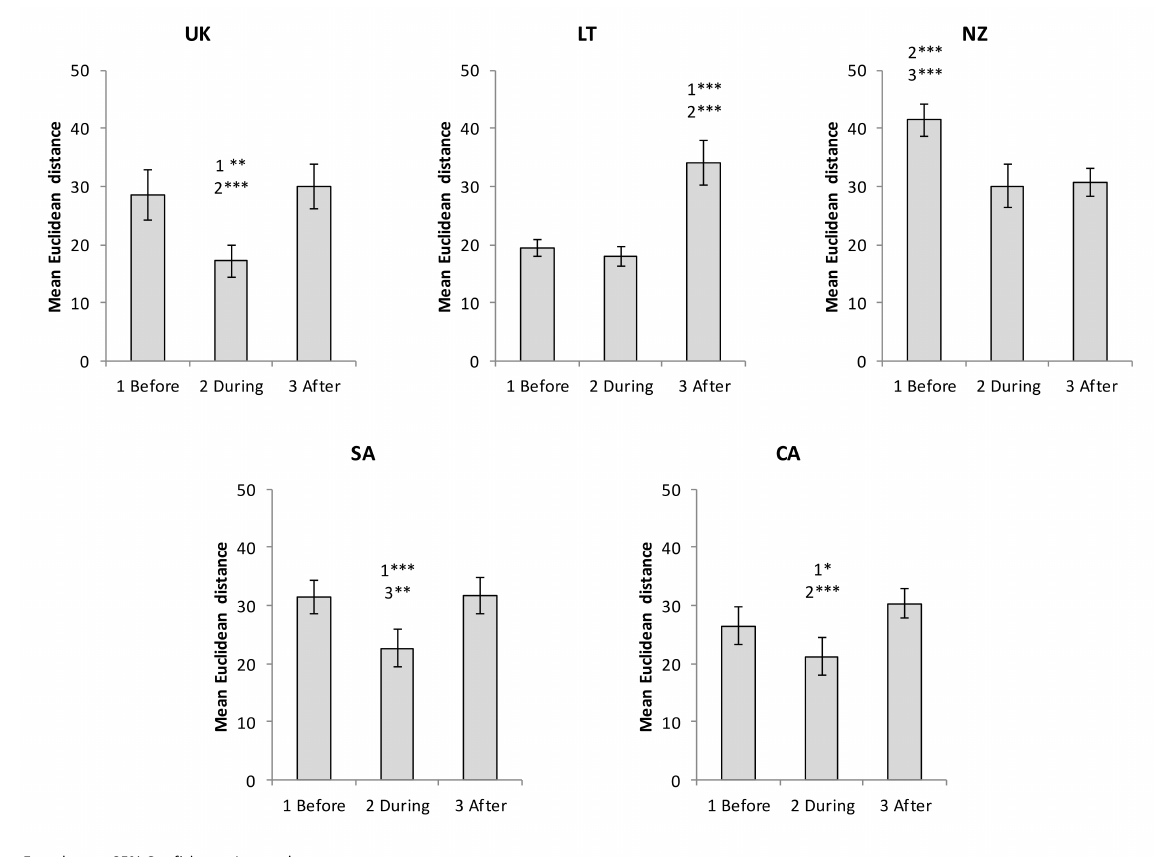
Figure 5. The results of a repeated measures (within-subjects) ANOVA test assessing differences in the pairwise heart rhythm synchronization for all five groups during 15-min periods before (1), during (2) and after (3) using the Heart lock-In technique (* corresponds to p < 0.05, ** corresponds to p < 0.001, *** corresponds to p < 0.0001). Note that in order to assess the pairwise heart rhythm synchronization between participants in one group, the Euclidean distance from the optimal time lag vectors of each participant to all other participants in the group was computed and mean Euclidean distance was calculated. The lower mean Euclidean distances correspond to the higher level of pairwise synchronization. It can be seen, for example, that the California’s group members’ heart rhythms were significantly more synchronized with each other during the HLI period than before and after the HLI period,